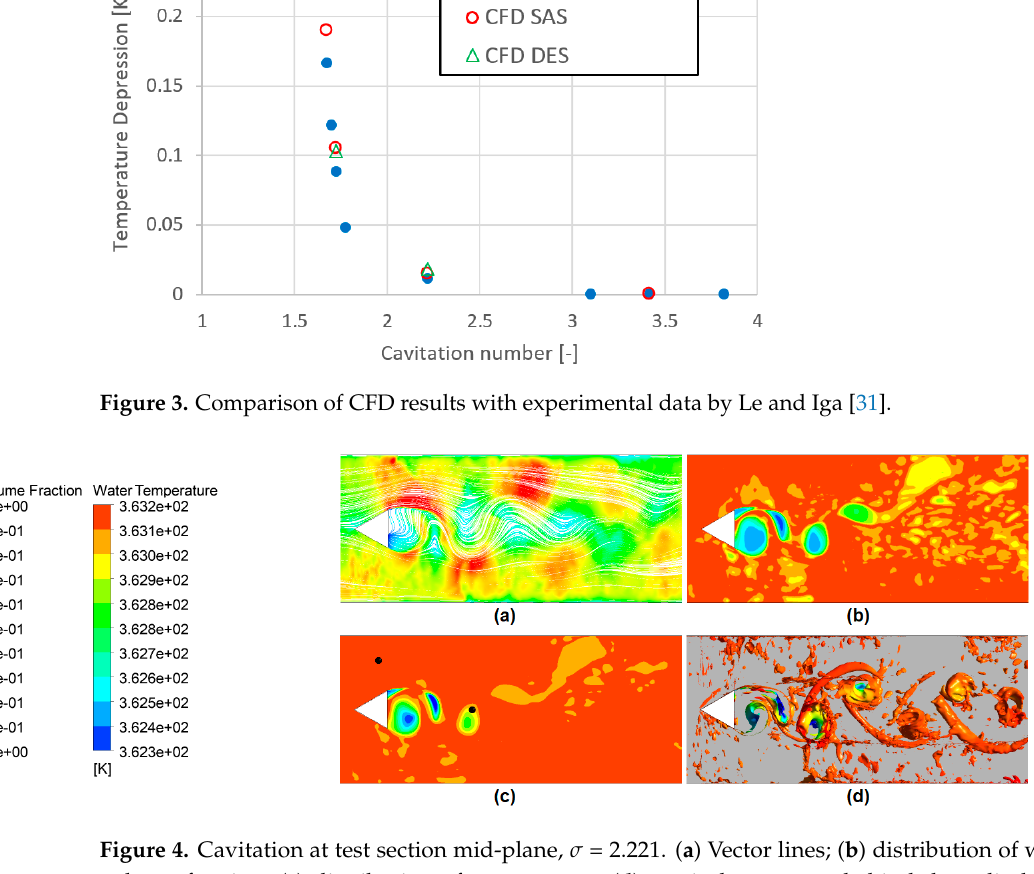
Figure 3. Comparison of CFD results with experimental data by Le and Iga [31].